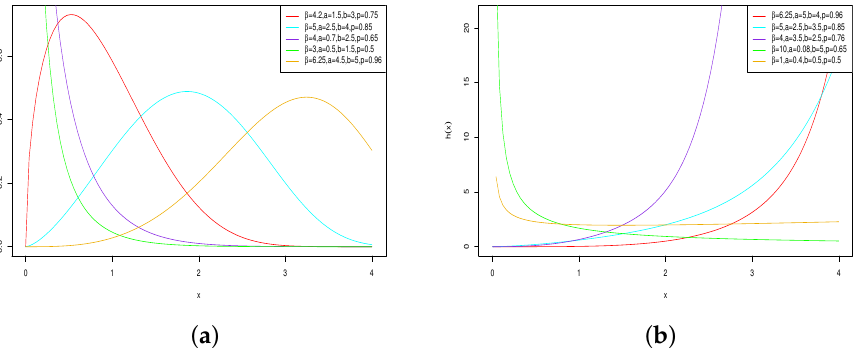
Figure 1. Examples of plots of the ( a ) pdf and ( b ) hrf of the OELW distribution for various values of p , β , a and b